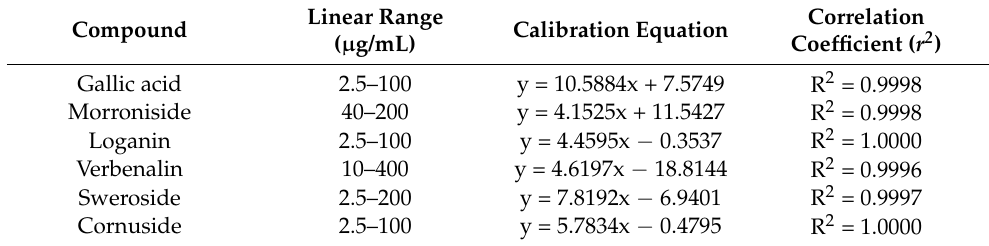
Table 2. Calibration equations and correlation